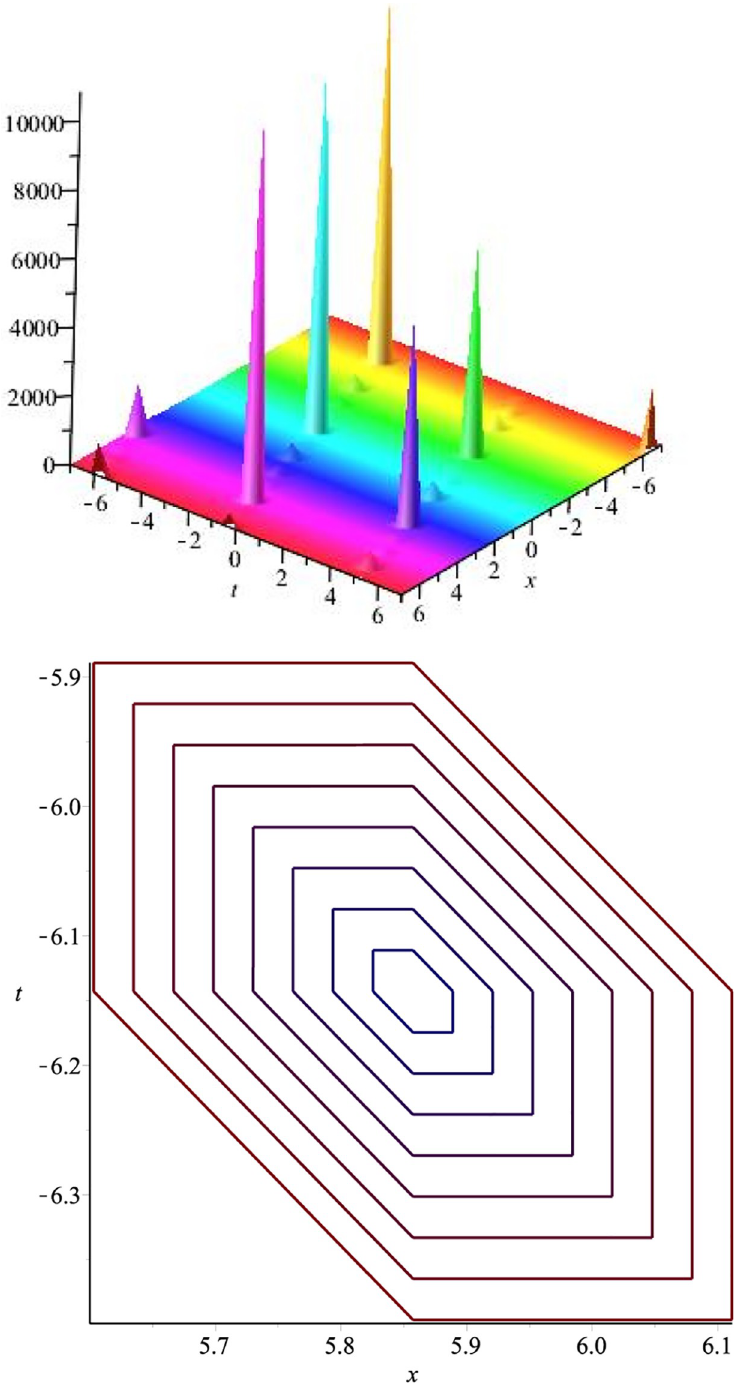
Fig 4. Singular soliton: j v 13 ( x , t ) j for l = − 0.9, m = − 1.8, λ = − 2.3, c = 2.7, v = 3.6, μ = 2.3.